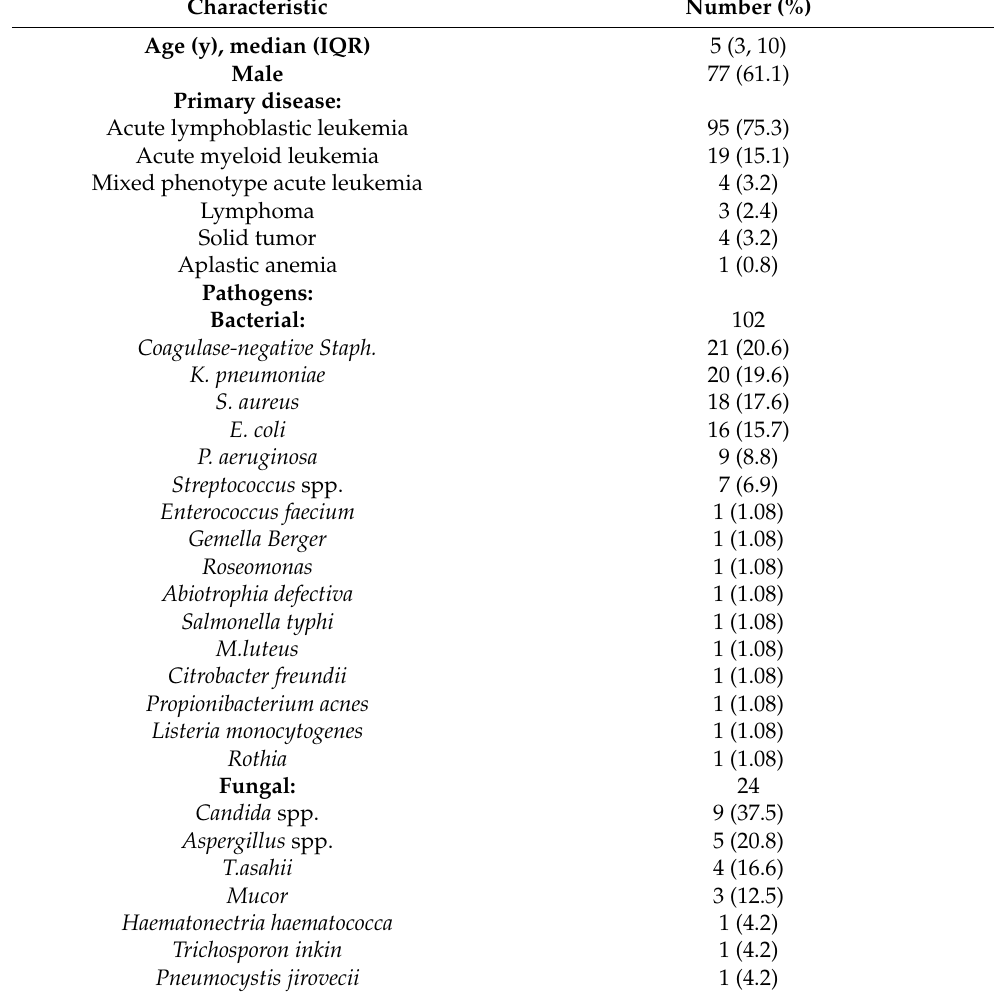
Table 1. Demographic and clinical characteristics of patients.